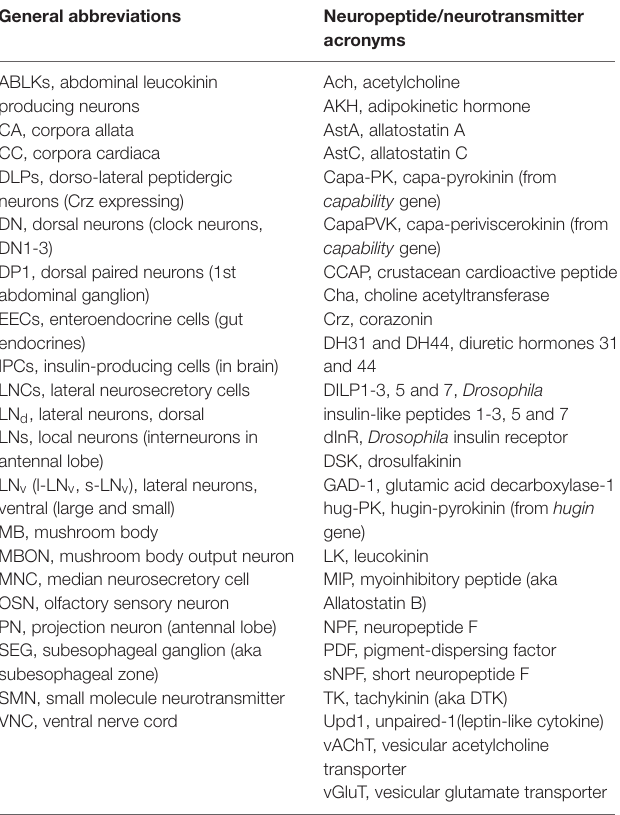
TABLE 1 | Abbreviations. General